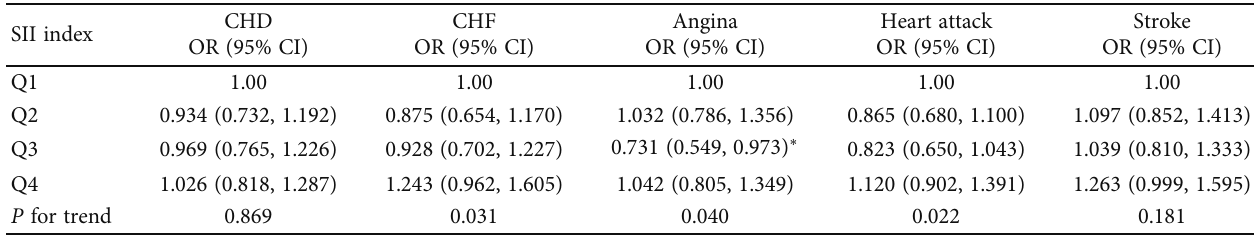
Table 3: Adjusted ORs for associations between SII index and individual